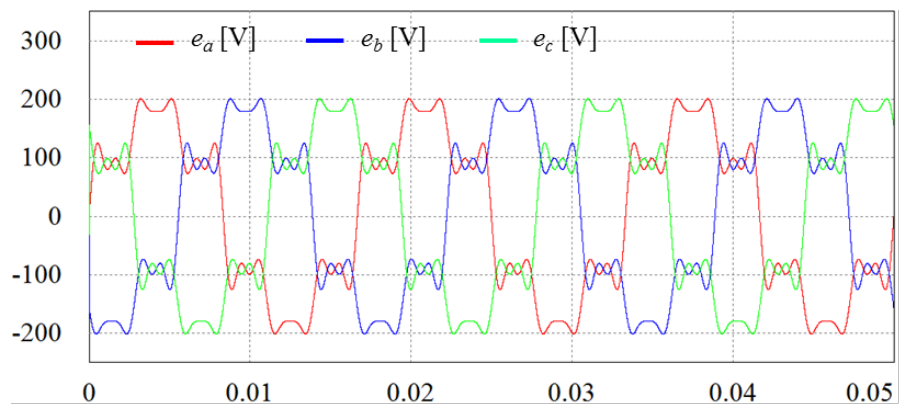
Figure 4. Distorted three-phase grid voltages.